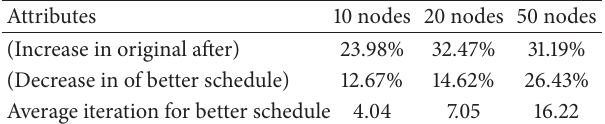
Table 4: Performance for DAGs with different number of nodes.